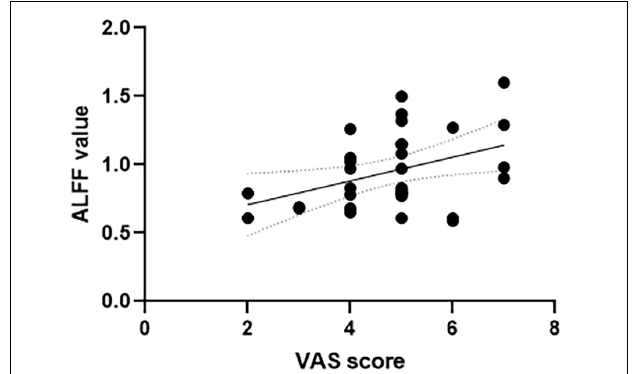
FIGURE 2 | Correlation between VAS scores and ALFF value of the left anterior cingulate and paracingulate gyri in the slow-4 frequency band of 0.027–0.073 Hz. VAS, Visual Analog Scale; ALFF, amplitude of low-frequency fluctuation.